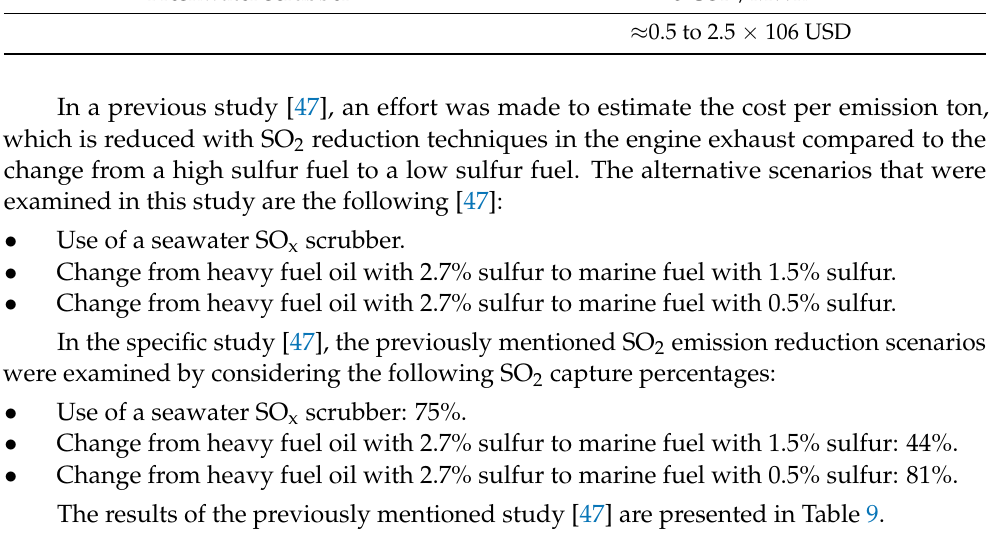
Table 9. Cost per ton of emitted pollutants reduced from the use of seawater scrubbers and from the change to low sulfur fuel. (Table was generated using data from refs.